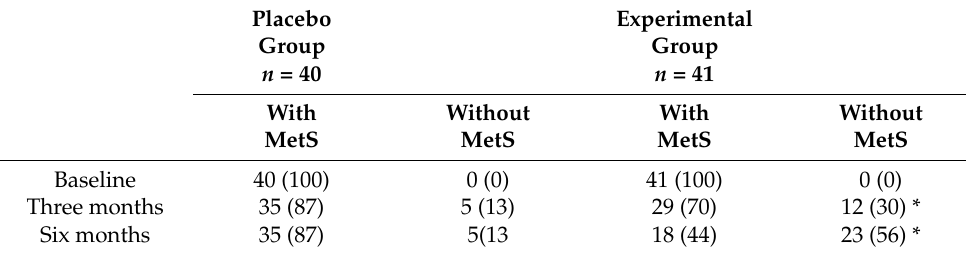
Table 6. Metabolic syndrome control after of three and six months of treatment. Placebo